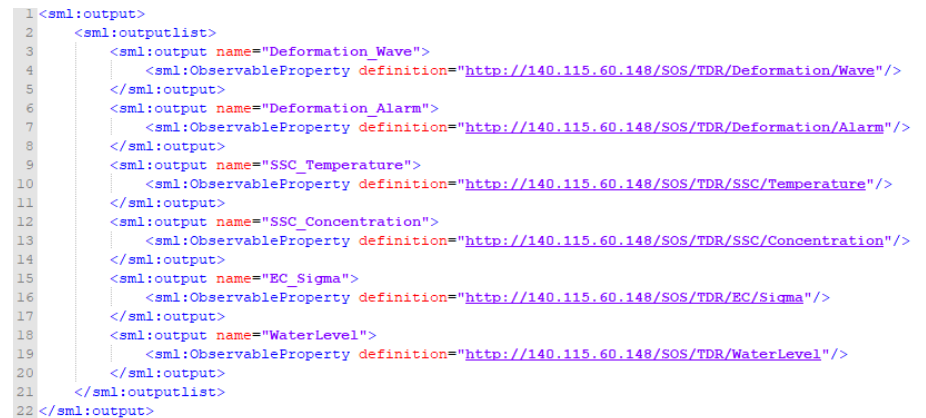
Figure 9. Insert sensor XML request of InsertSensor_outputs.